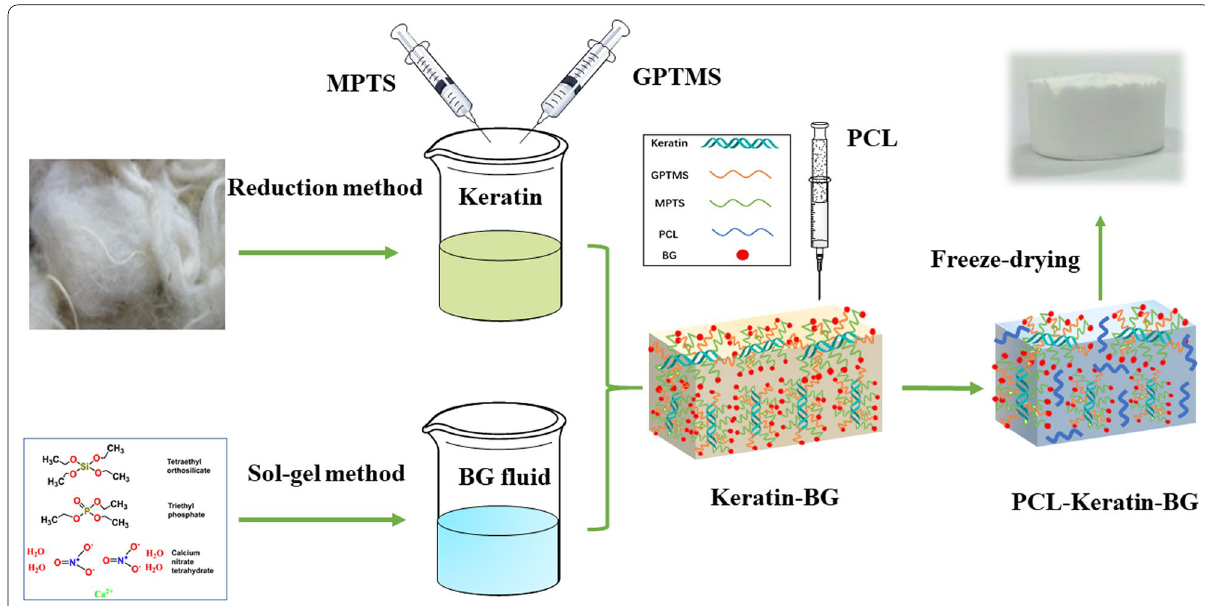
Fig.1 Schematic illustration of preparation of PCL-Keratin-BG composite